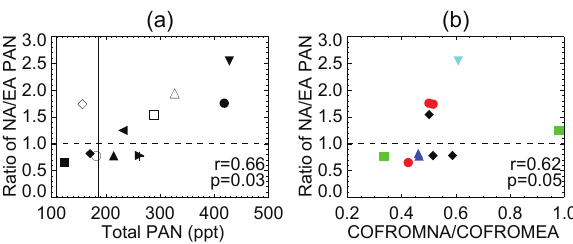
Figure 6. Ratio of the PAN response to 20% emission reductions within NA to that from EA plotted against (a) total PAN and (b) the ratio of idealized tracers of model transport emitted from NA to that from EA (COfromNA/COfromEA; see Table 2) at Mount Bachelor as simulated by the HTAP1 models. Each symbol in (a) represents a model as defined in Table 1; the range of observed total PAN at Mount Bachelor is indicated by the black vertical lines. The col- ored symbols in (b) represent the meteorological fields used in the simulation: blue triangles for GEOS winds, red circles for NCEP, black diamonds for ECMWF, cyan upside-down triangles for the Canadian Meteorological Centre, and green squares for general cir- culation models forced by observed sea surface temperatures and sea ice. Both panels show Spearman’s rank correlation coefficients and p values, as well as a black dashed horizontal line at 1 to sep- arate the models suggesting a higher NA influence (above) versus higher EA influence (below) on PAN